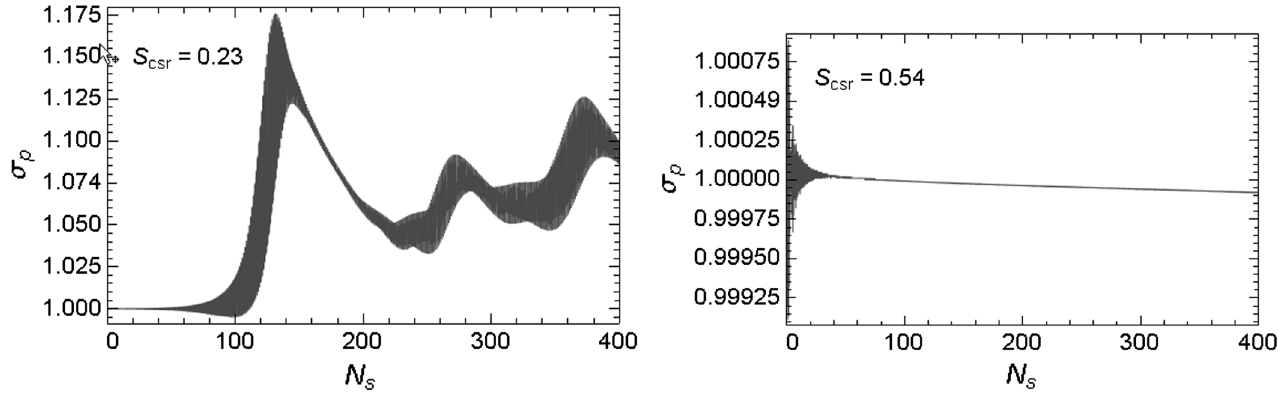
FIG. 6. For shielded CSR with (cid:1) ¼ 0 : 7 and nominal damping, rms of p coordinate, (cid:6) S csr ¼ 0 : 23 and 0.54.